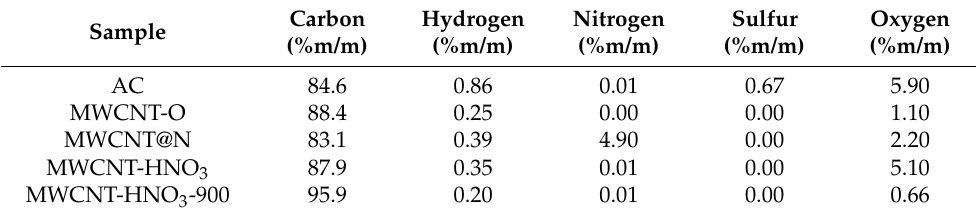
Table 3. Elemental analysis of selected carbon